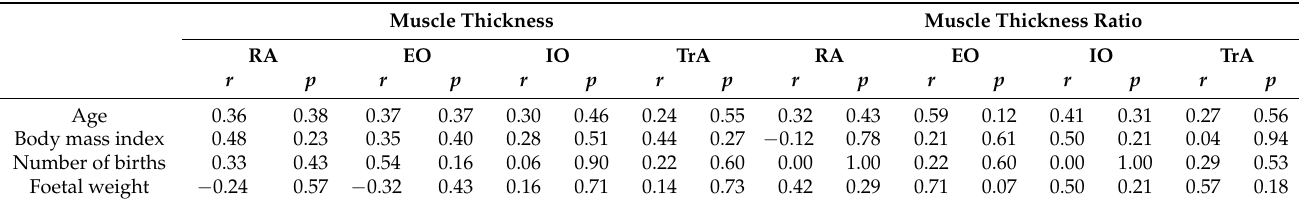
Table 4. Correlations between muscle thickness and muscle thickness ratios at six months after childbirth and maternal and foetal